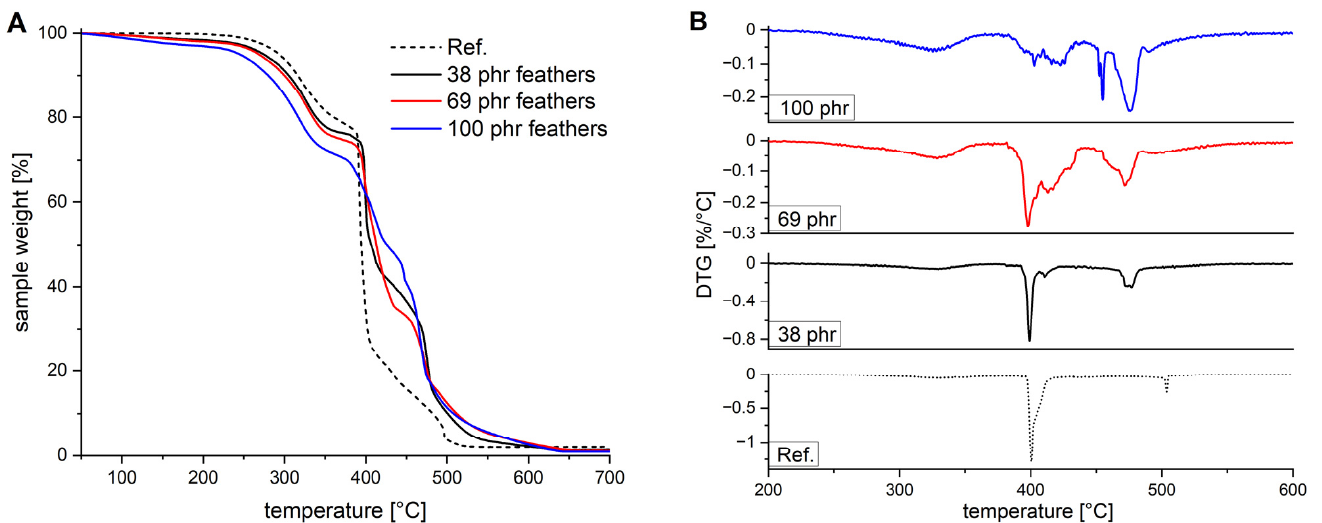
Figure 7. Thermogravimetric analysis (TGA) data ( A ) and DTG ( B ) of EPDM (M1) filled with different amounts of 0.08 mm feathers heated with 10 °C /min under oxygen atmosphere. A vulcanised M1 mixture without feathers is used as reference.